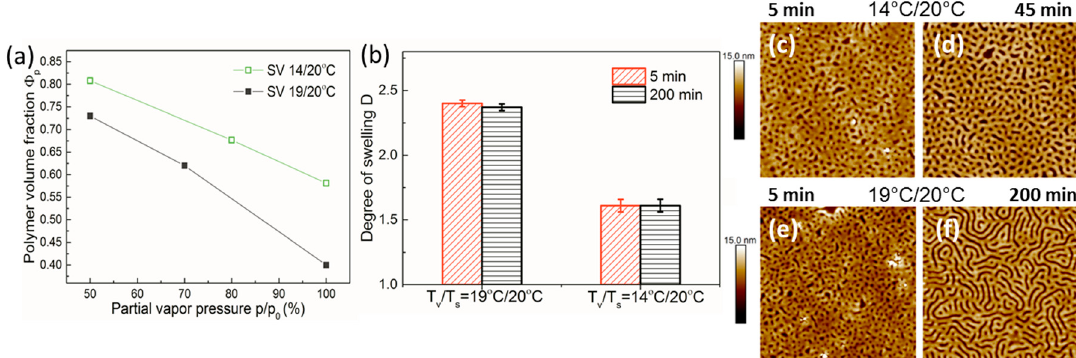
Figure 4. ( a ) Polymer volume fraction Φ p of PS-PVP films (indicated as SV) with a dry thickness of ~40 nm upon stepwise increase of p / p 0 of chloroform at indicated temperature sets T v / T s . Φ p is calculated from the measurements of the dry and the swollen film thicknesses as h dry / h sw . ( b ) Degree of swelling D of 40 nm thick PS-PVP films annealed at 100 sccm flow of 100% p / p 0 of chloroform after 5 min and after 200 min of processing under T s = 20 ◦ C and T v = 14 or 19 ◦ C, as indicated. Scanning force microscopy (SFM) height images of the surface morphology in PS-PVP films after 5 min ( c , e ), 45 min ( d ), and after 200 min ( f ) of annealing at indicated temperatures. The scan area is 3 × 3 µ m 2 .